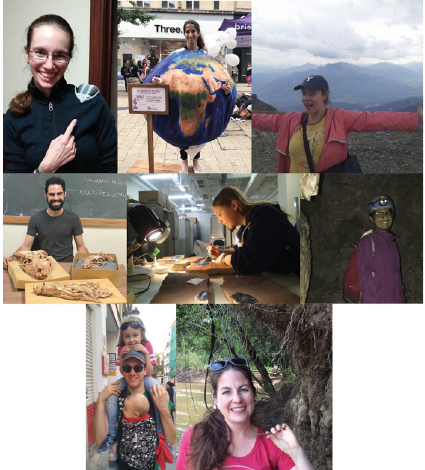
Fig. 1 Image is a collage of images of 8 people, organized into 2 connected rows of 3 images and a third row of 2 images. The fi rst 6 images are of current steering committee members. The top left image is a headshot of Elizabeth Sibert, a white woman with brown hair in a ponytail, wearing glasses. She is wearing a black jacket and has a gray 3D printed trilobite on her shoulder, which she is pointing to. The top middle image is a picture of Rehemat Bhatia, a brown-skinned woman, wearing a globe costume depicting the Earth. Her hair is tied back in a ponytail, and she is standing on a wooden box in a pedestrianised shopping area. The top right image is a photo of Jana Burke, a white woman wearing a baseball hat and a pink jacket on a mountain in Flims, Switzerland. Her arms are outstretched and she is grinning, with clouds and mountains in the background. The second-row left image is a picture of Pedro Godoy, a brown-eyed, dark- haired, and bearded man, wearing a dark gray T-shirt. He is smiling and sitting in front of a blackboard, on which the names of two crocodylomorph species can be read. In front of him, on a wooden table, there are three skulls of fossil crocodylomorphs. The second-row middle image is of Chrissy Hall, a white woman wearing a dark jacket. She is in a museum collections room painting liquid latex onto fossils, using a lamp to help them dry. The second-row right image is Natasha Sekhon, a brown-skinned woman, wearing glasses and in a pink rain jacket, brown pants with a red backpack. She is wearing a cave helmet with two headlamps and nitrile gloves. She is standing inside a cave in south-eastern New Mexico. The lower images are of former committee members. The lower left-hand image is of Andy Fraass, a white-skinned man, wearing a green shirt, grey hat, sunglasses, and a wedding band. He has a white-skinned young girl on his shoulders in a pink t-shirt with two white stripes on the sleeves and jeans. He also has a white-skinned baby strapped to his chest in a black and white child carrier. They are walking on a sidewalk in a city. The lower right- hand image is of Catherine Davis, a white woman with brown hair, wearing a red shirt with sunglasses on her head. She is standing on a muddy bank of the PeeDee River holding a belemnite and